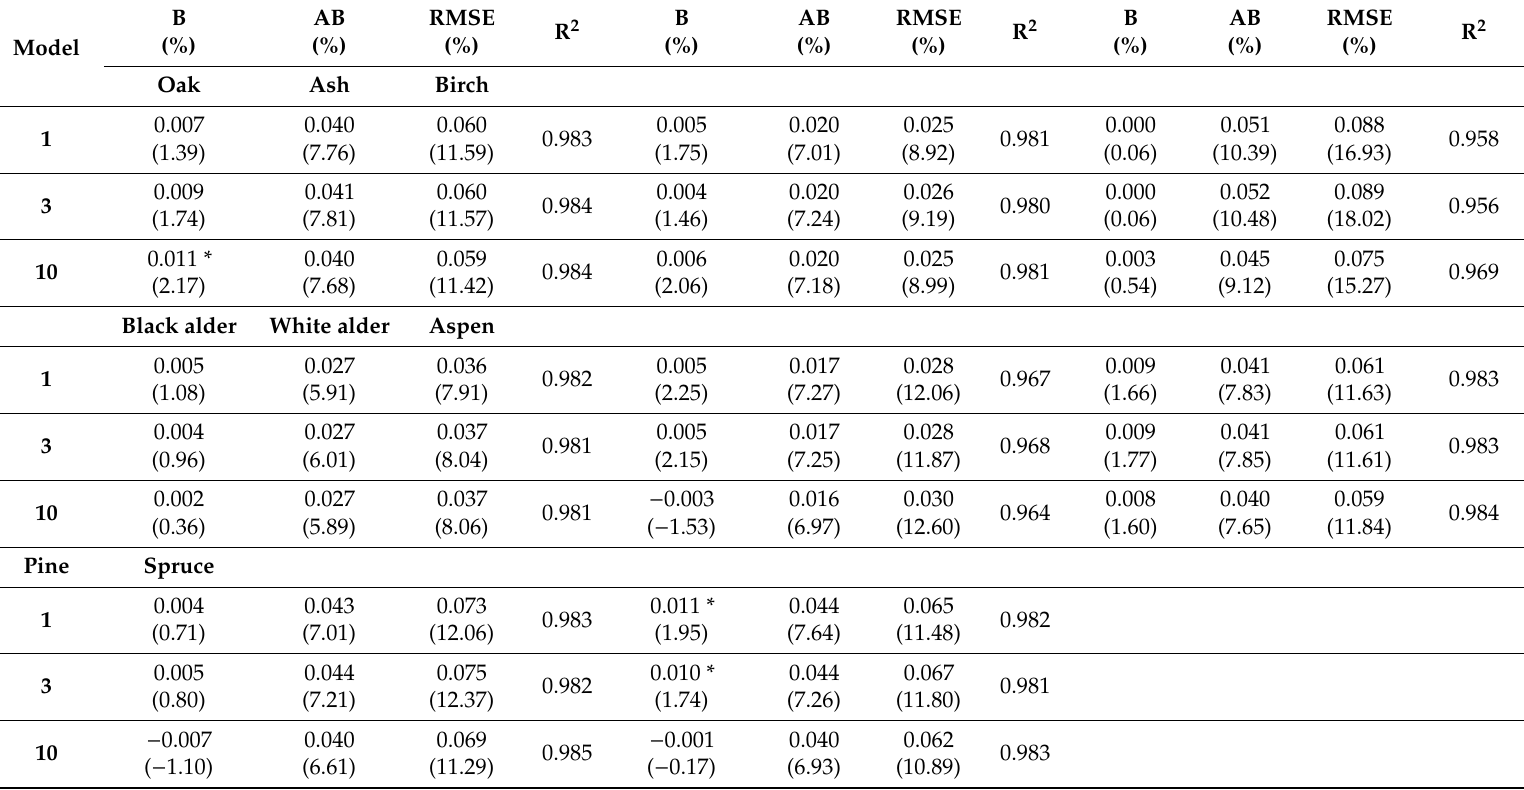
Table 6. Statistical measures for all fitted volume